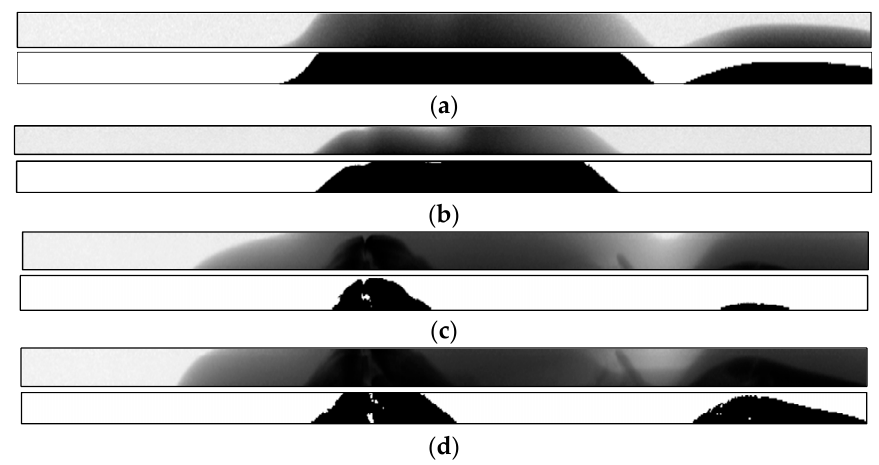
Figure 6. Segmentation results of four selected images in the sequence. ( a ) Sequence image 1; ( b ) sequence image 2; ( c ) sequence image 3; ( d ) sequence image 4.